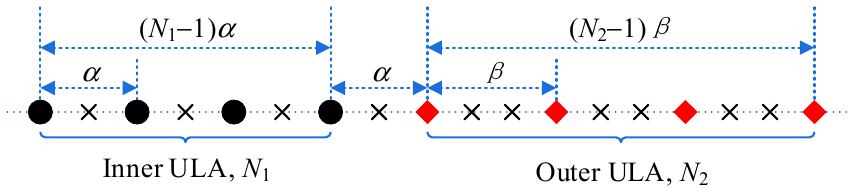
Figure 1. Generalized nested array, where we assume N 1 = N 2 = 4. Black circles and red diamonds denote the inner ULA and outer ULA, respectively. Black crosses imply empty space when α > 1, β > 1.